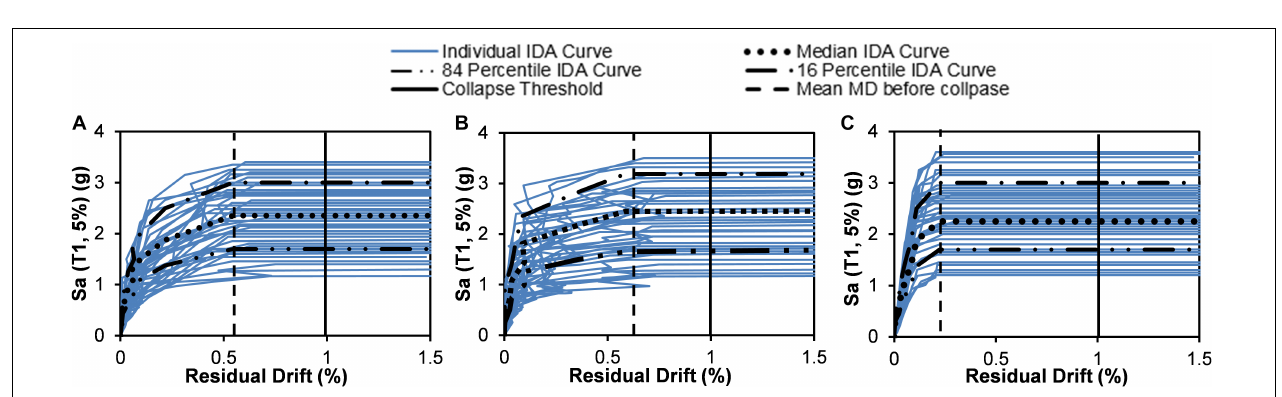
FIGURE 12 | IDA curves for maximum drift for Steel reinforced concrete bridge bent (Steel-RC) (A) short duration motion (B) long duration motion.